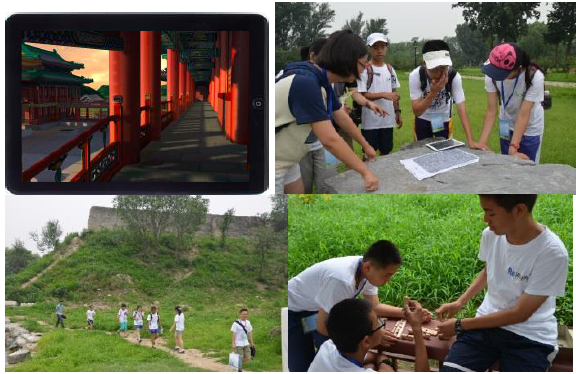
Figure 5. Moments of the “ History Is FUN” Summer Camp